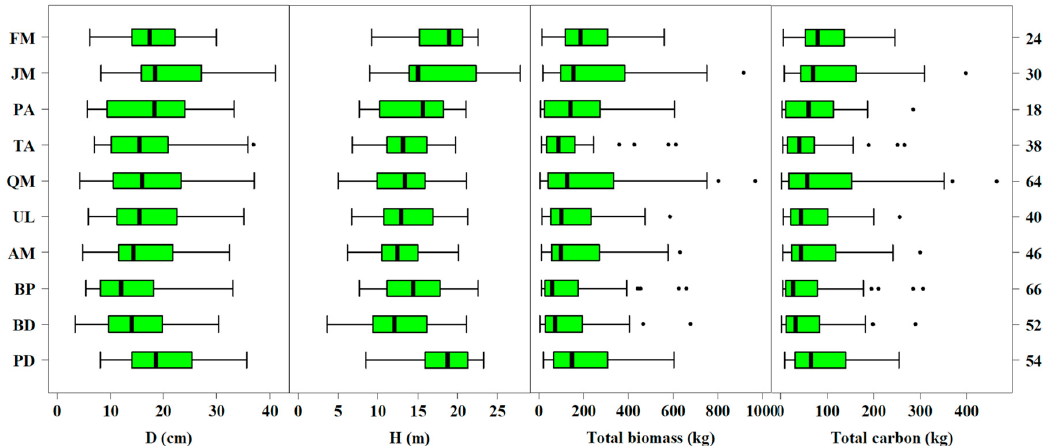
Figure 2. Boxplots of diameter at breast height ( D ), total tree height ( H ), total biomass, and carbon for 10 tree species. Numbers on the right-hand side indicate the number of sample trees. FM: Fraxinus manshuric ; JM: Juglans mandshurica ; PA: Phellodendron amurense ; QM: Quercus mongolica ; TA: Tilia amurensis ; UL: Ulmus laciniata ; AM: Acer mono ; BP: Betula platyphylla ; BD: Betula davuria ; PD: Populus davidiana